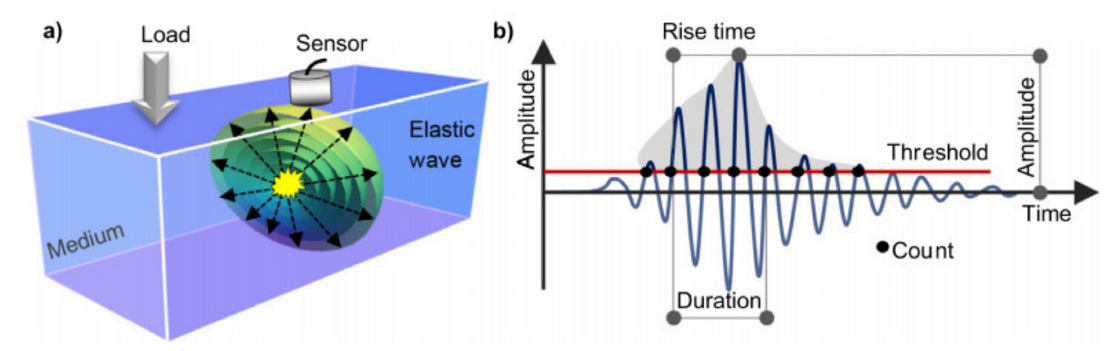
Figure 11. Acoustic emission principle: ( a ) AE sensor and medium; ( b ) AE parameters